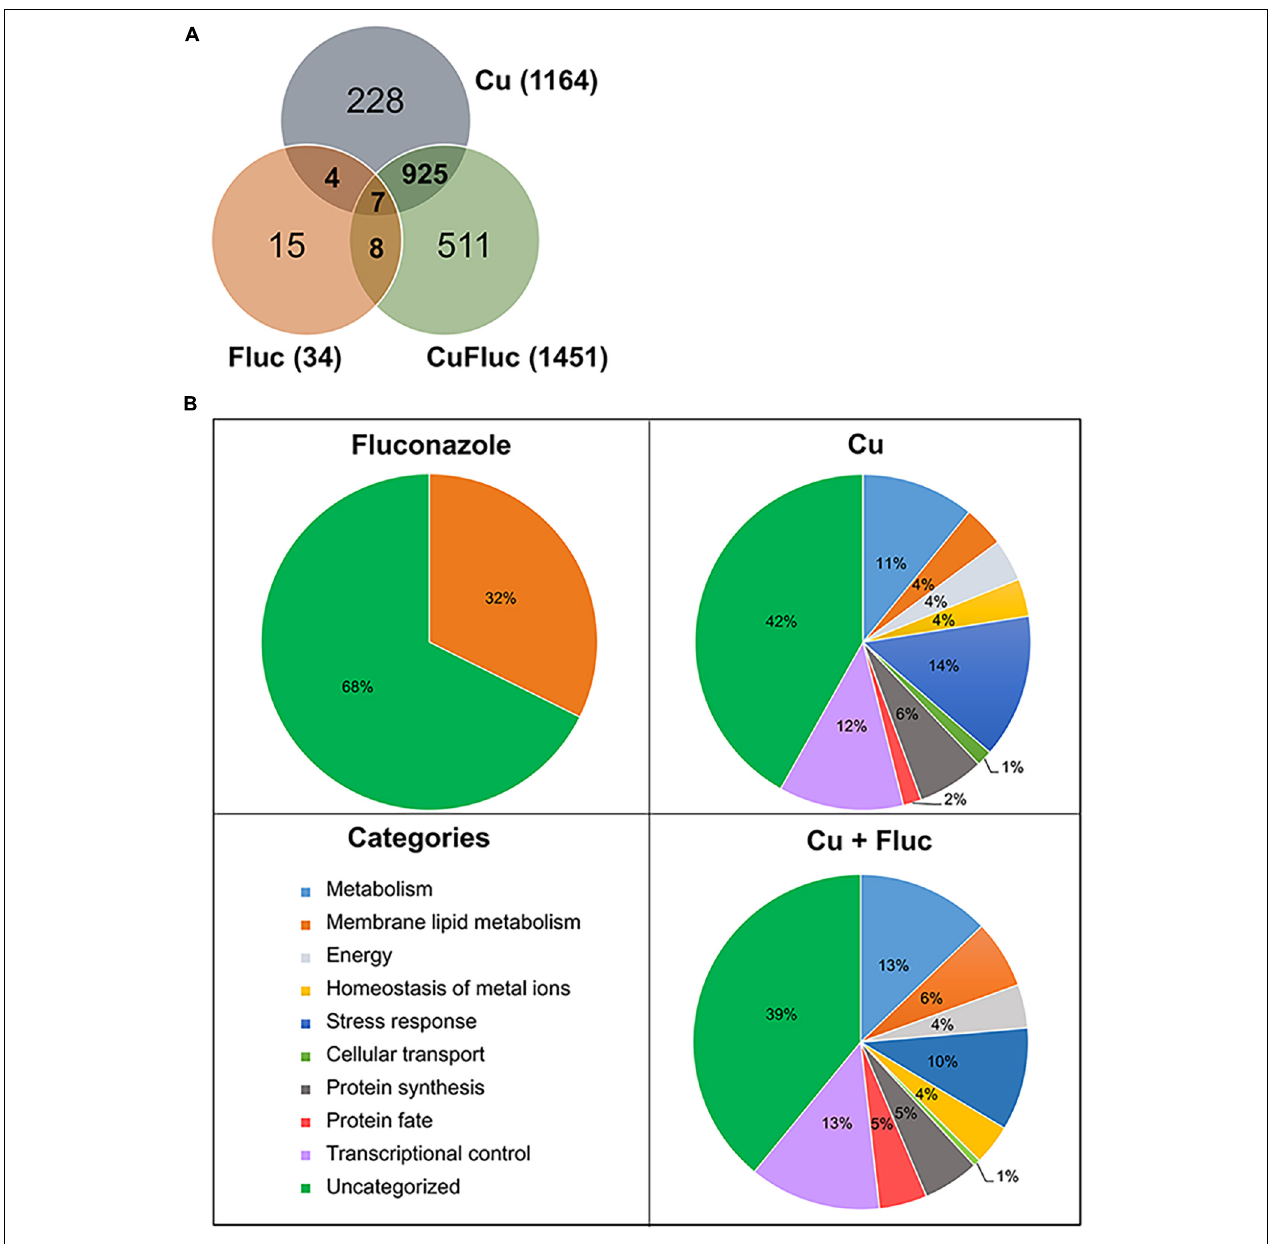
FIGURE 3 | Transcriptional response of Candida glabrata to copper and fluconazole. (A) Venn diagram representing the number of genes differentially expressed. The total number of differentially expressed genes in each condition (treated versus untreated) is indicated in parentheses. (B) Functional categorization of the differentially expressed genes based on corresponding encoded (or putatively encoded) proteins. Only enriched categories ( p -value < 0.05) are